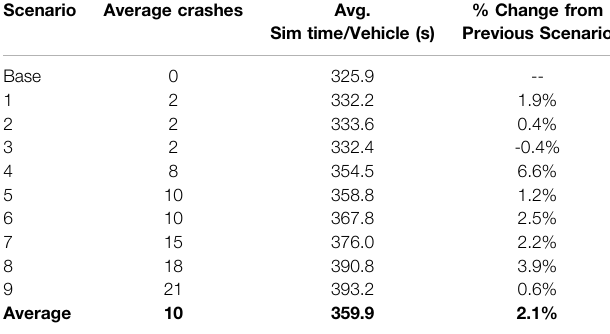
TABLE 3 | DoS results compared by scenario.